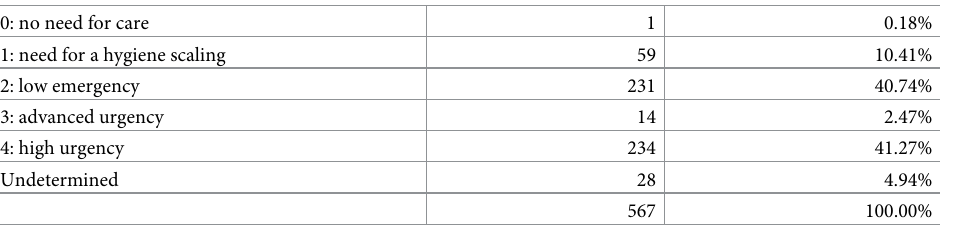
Table 7. Distribution of urgency score �